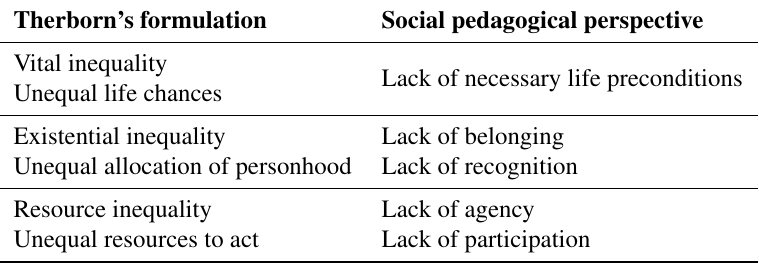
Social pedagogical perspectives on the dimensions of